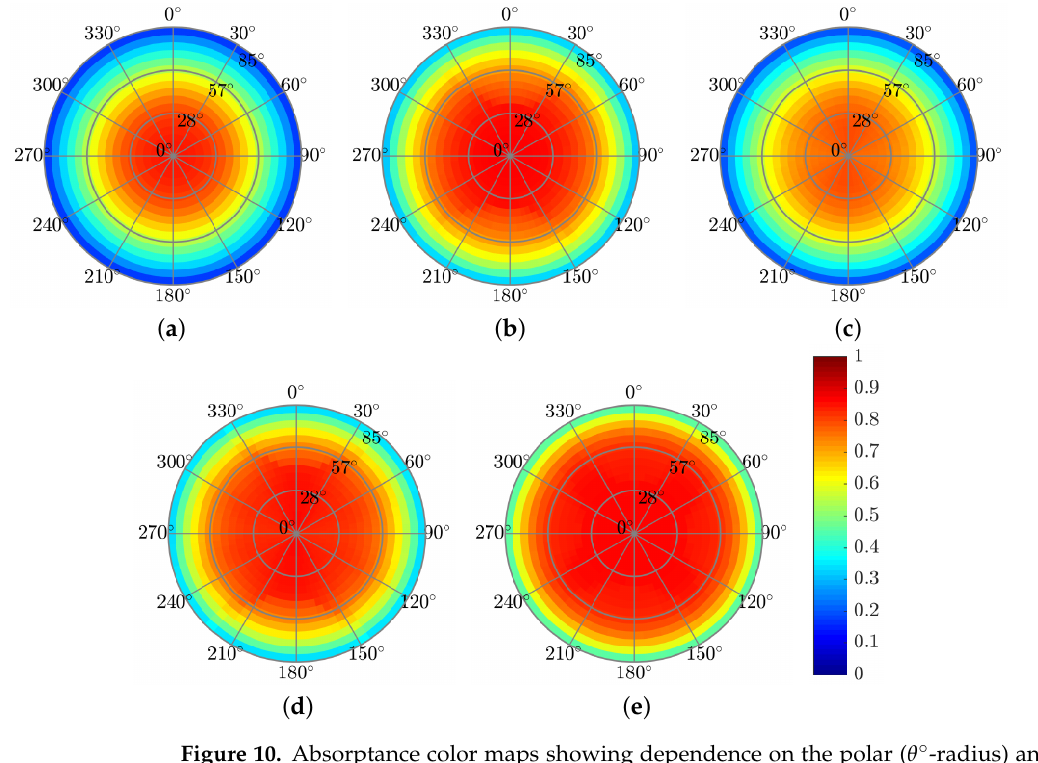
Figure 10. Absorptance color maps showing dependence on the polar ( θ ◦ -radius) and azimuthal ( φ ◦ -angle) incident angles at λ = 600 nm. ( a ) Reference. ( b ) Structure A. ( c ) Structure B. ( d ) Structure C. ( e ) Pyramid A.